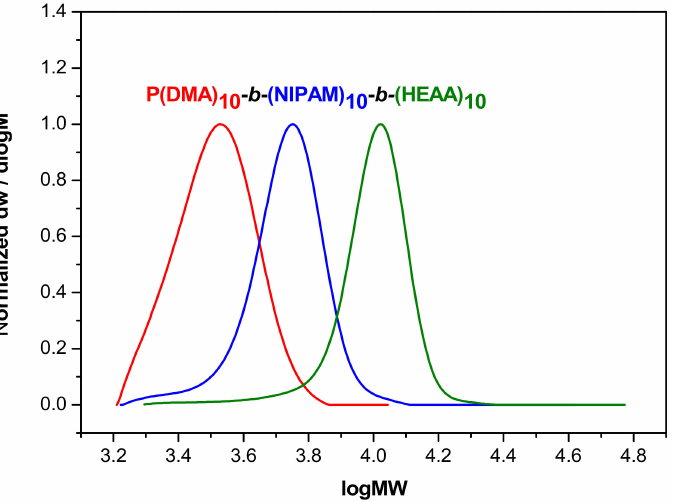
Figure 3. The evolution of molecular weights of successive block extensions of DMA, NIPAM and HEAA by iterative Cu(0)-mediated